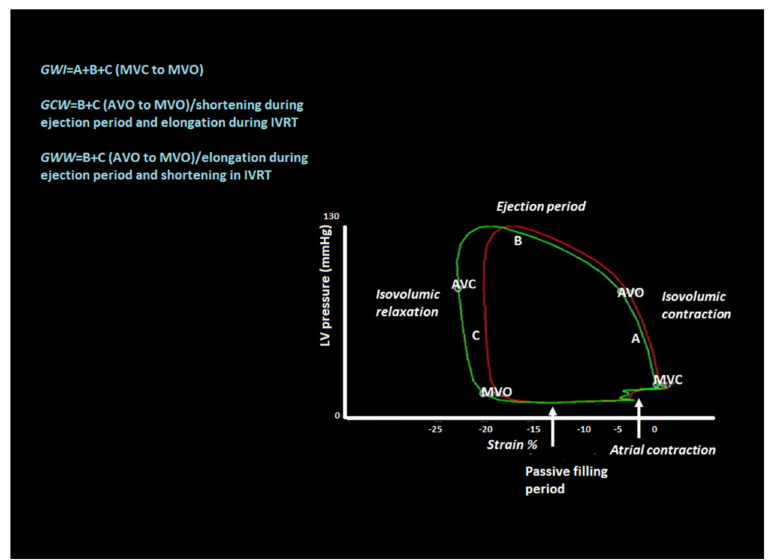
Figure 1. Pressure–strain loop (PSL) with valvular event timing and cardiac cycle phases. Global work index (GWI) represents the area of the loop from mitral valve closure (MVC) to mitral valve opening (MVO). Global constructive work (GCW) reflects the work that contributes to pump from aortic valve opening (AVO) to MVO. There is shortening during the ejection period and lengthening during isovolumic relaxation (IVRT). Global wasted work (GWW) represents the work that does not contribute to ejection. There is elongation of myocytes during the ejection period and shortening after the aortic valve closure (AVC) during IVRT.